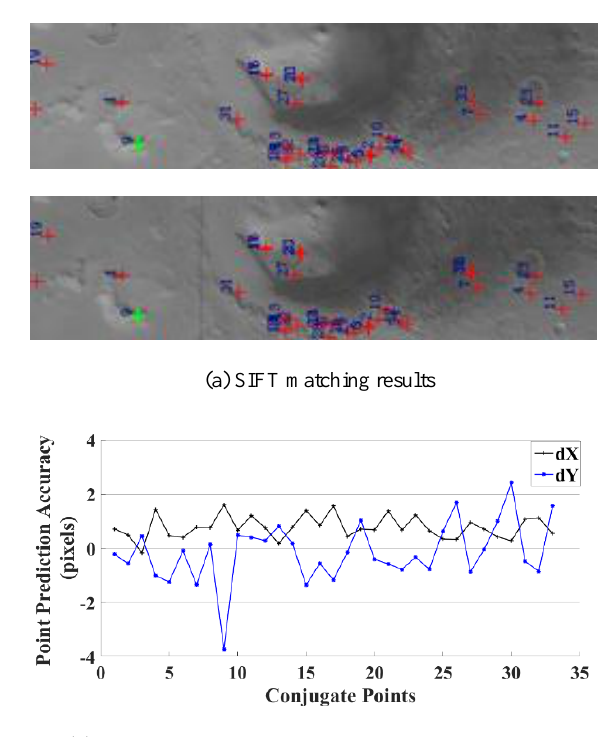
Figure 2. Image matching results on the third pyramid level of HRSC Level-3 images using SIFT